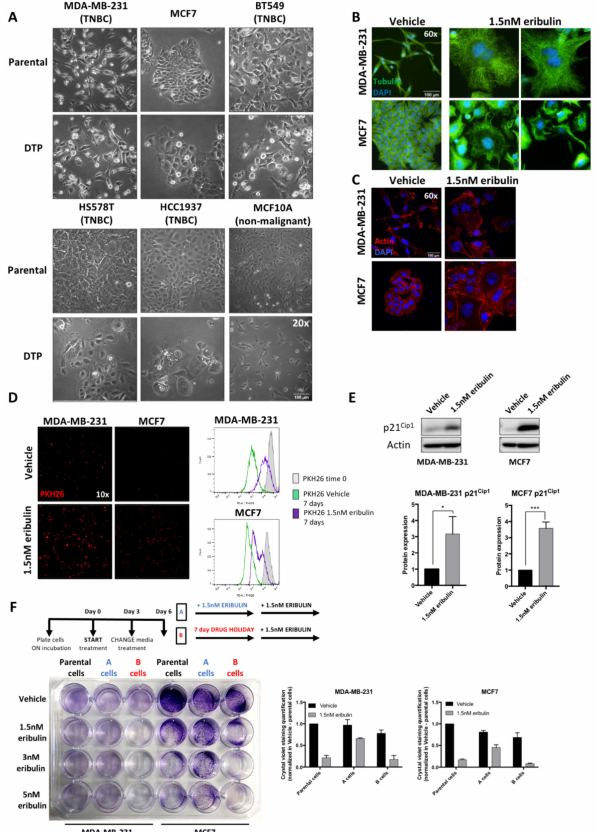
Figure 1. Eribulin treatment in vitro leads to the formation of a drug-tolerant persister (DTP) subpop- ulation. ( A ) (Upper panel) (Lower panel) Representative images of parental (cells